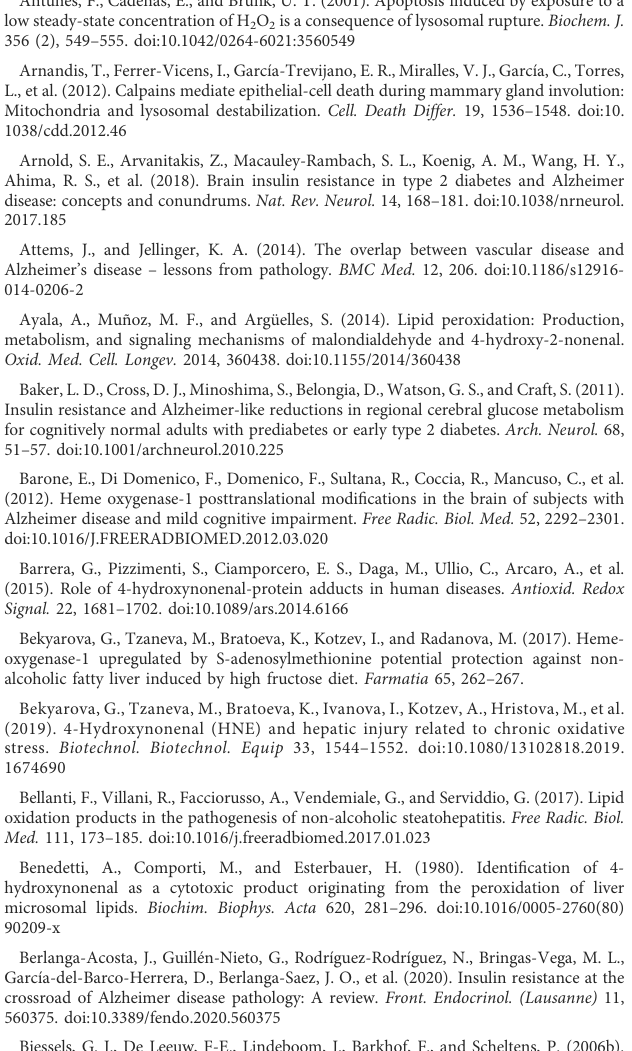
experiments, PB: generation of Figure 5, SO and HK: generation of Figure 9, EM: editing. Figure